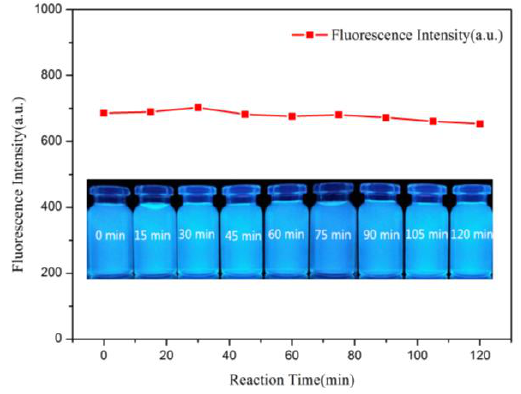
Figure 3. Photostability study of FCNs under UV light irradiation.